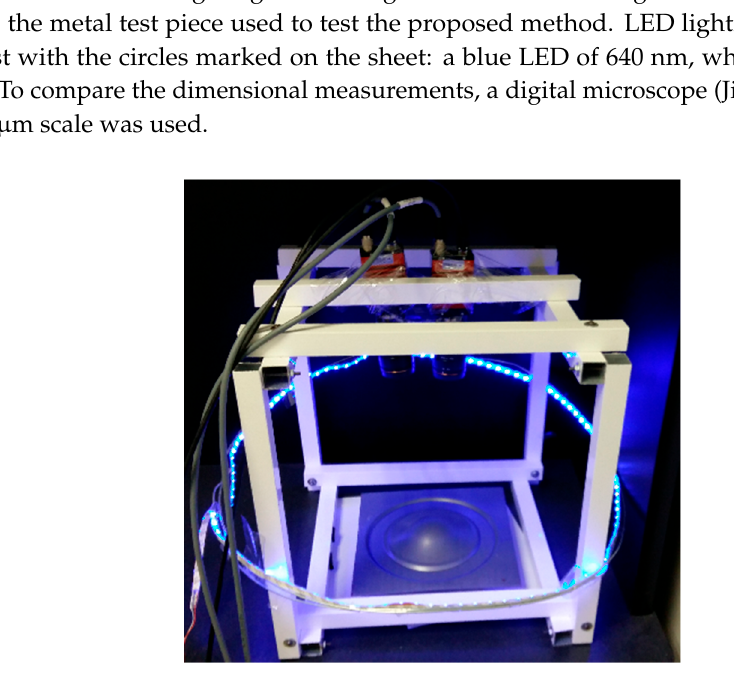
Figure 3. Setting of stereo cameras with illumination and metal sheet. Figure 4. Setting of stereo cameras with illumination and metal